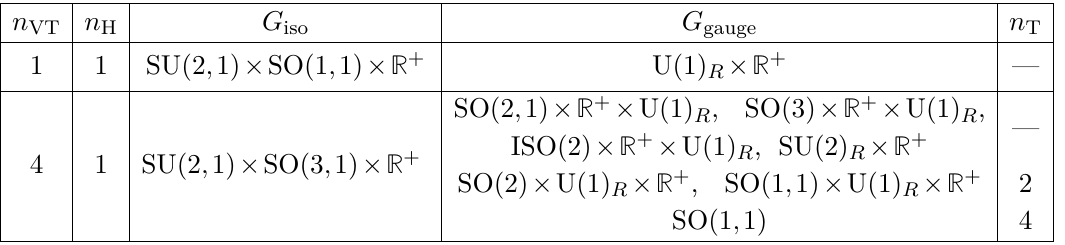
Table 4 . Summary of the gauge groups in the mixed cases. The first column gives the total number of vectors and tensor multiplets, the second the global isometry group, the third the allowed gaugings and the last one the number of vectors that are dualised to tensors in each